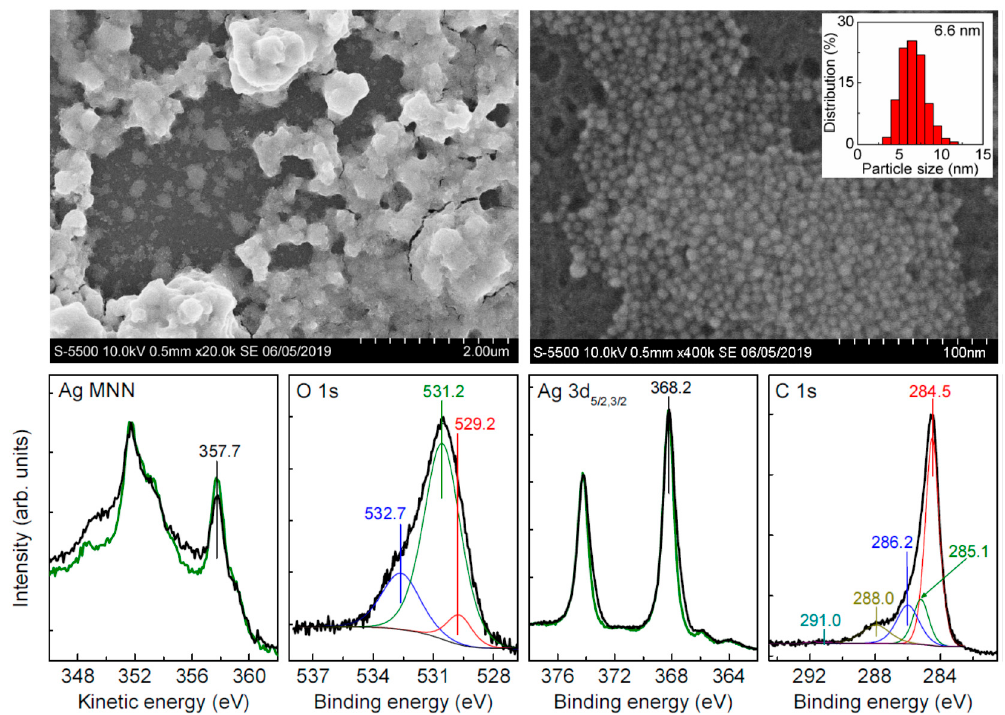
Figure 3. SEM images, particle size distribution, and photoelectron spectra of deposited Ag NPs and conditioned in 7 wt. % H 2 O 2 solution for 5 min. For comparison, the Ag 3d and Ag M 5 NN spectra of intrinsic nanoparticles (Figure 1) are shown as green lines.